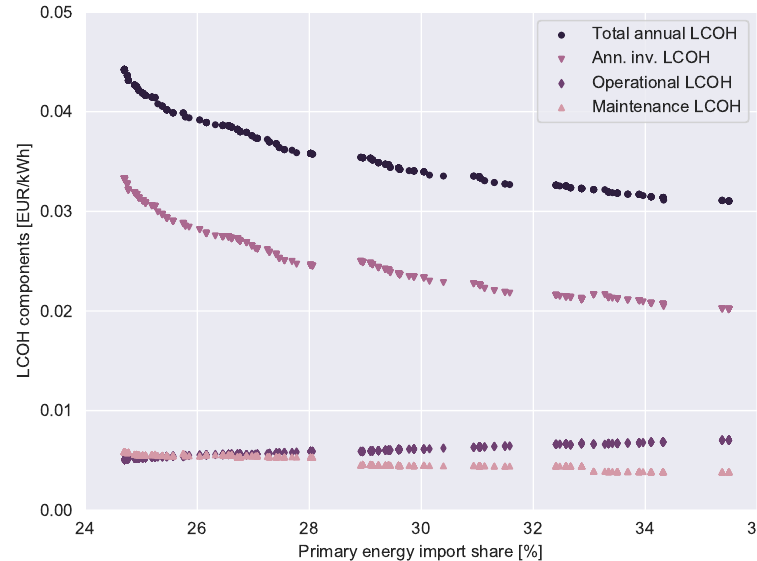
Figure 4. Different contributions to the total annual LCOH for the reference case, namely that of annual maintenance, operational cost and annualised investment cost. The annualised investment has the largest contribution.